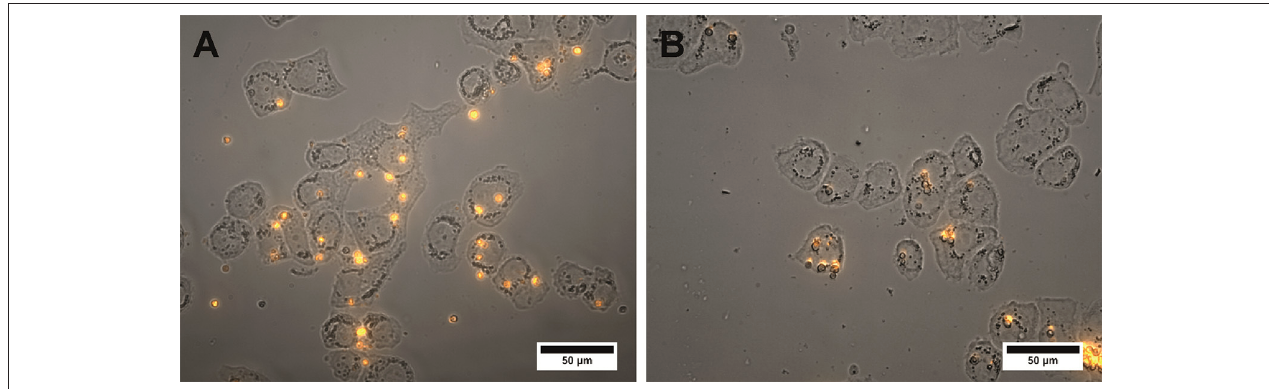
FIGURE 5 | Microphotographs of the SK-BR-3 cells after overnight exposure to the QD-encoded microcapsules conjugated with (A) trastuzumab and (B) non-conjugated QD-encoded microcapsules are shown. The amount of the microcapsules was 20 per cell. The image represents a merge of a brightfield and fluorescent channels. Image processing was performed using the Image J 1.48v